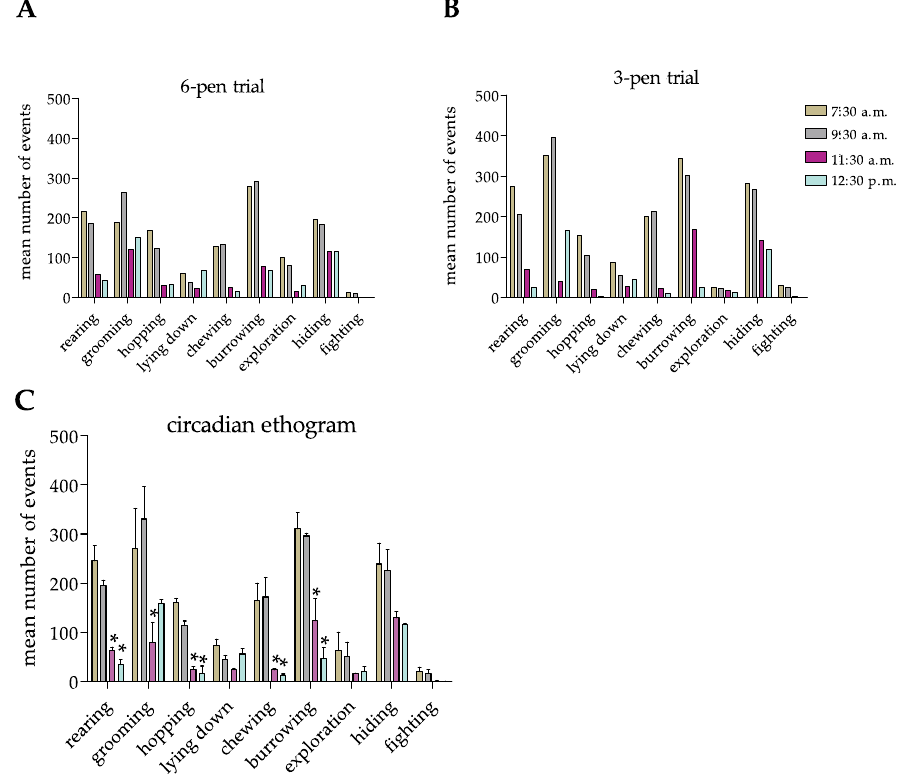
Figure 4. ( A , B ) Rabbits’ circadian ethogram during the 6-pen trial and 3-pen trial. Data are displayed as arithmetic means ( A , B ) or means + SEM ( C ). Mean number of events was counted over a period of four weeks in the 6-pen/3-pen trials ( n = 6 animals per trial). Parametric data were analyzed by two-way repeated measure ANOVA to identify significant differences between time points and tri- als ( C ). Significant differences between time points compared to 7:30 a.m. are indicated by an aster- isk ( p -value < 0.05). 4. Discussion In this study, we implemented a novel, mobile housing system (mobile-R-pen) for rabbits that provides spatial flexibility. Our analyses revealed species-specific behavioral patterns of group-housed female NZW rabbits in a larger enclosure as well as in size- restricted compartments. Size restriction led to no general alteration of NZW rabbits. We observed that hiding was significantly decreased with size restriction. Moreover, fighting was increased in 6-pen versus 3-pen trials, indicating enhancing species-specific behavior that accompanies hierarchy establishment. In line with this notion is the finding that size restriction is a stressor that impacts social structure establishment in female NZW rabbits [17]. The time animals spent hiding was significantly increased in the 6-pen trial, while the number of hiding events was lower in the 3-pen trial. Interestingly, the time animals spent hiding decreased after size restriction of the already familiar environment. This might be an indication that social stress affects animals and prevents them from resting for longer periods of time. It has been reported that self-grooming increases after size restriction, while explorative behavior increases with enclosure size for NZW rabbits [15]. We demon- strate that the time animals spent exploring the enclosure drops in parallel to the number of exploratory events in the 3-pen trial compared to the 6-pen trial. Thus, space affects animal behavior and, in turn, the outcome of experiments. Our data are in line with recent reports indicating that the size and shape of the enclosure are critical variables that might induce stressful situations for group-housed rabbits [16]. Of note, the floor size of a single mobile-R-pen module exceeds the minimal space recommendations of the European di- rective by 2.3 times, allowing optimal adaptations for young and adult rabbits [1]. Moreover, we identified fighting events, but no injuries, which has been observed after re-grouping of rabbits in an unfamiliar pen by others [18]. Furthermore, we did not identify fighting events during our baseline behavior analyses in the 6-pen trial, which might indicate that first introducing animals to a larger, unfamiliar environment reduces aversive behavior prior to size restriction [17]. The time animals spent fighting was signif- icantly different in the 6-pen trial compared to the 3-pen trial in that the number of fighting events increased after size restriction. This indicates that sufficient space promotes the establishment of social hierarchy. Moreover, space restrictions led to increased fighting, most likely due to special stress. Sufficient space to escape and adequate enrichment items to hide in or behind might therefore improve animals’ well-being and prevent injuries and intense fights, even after re-grouping [19].